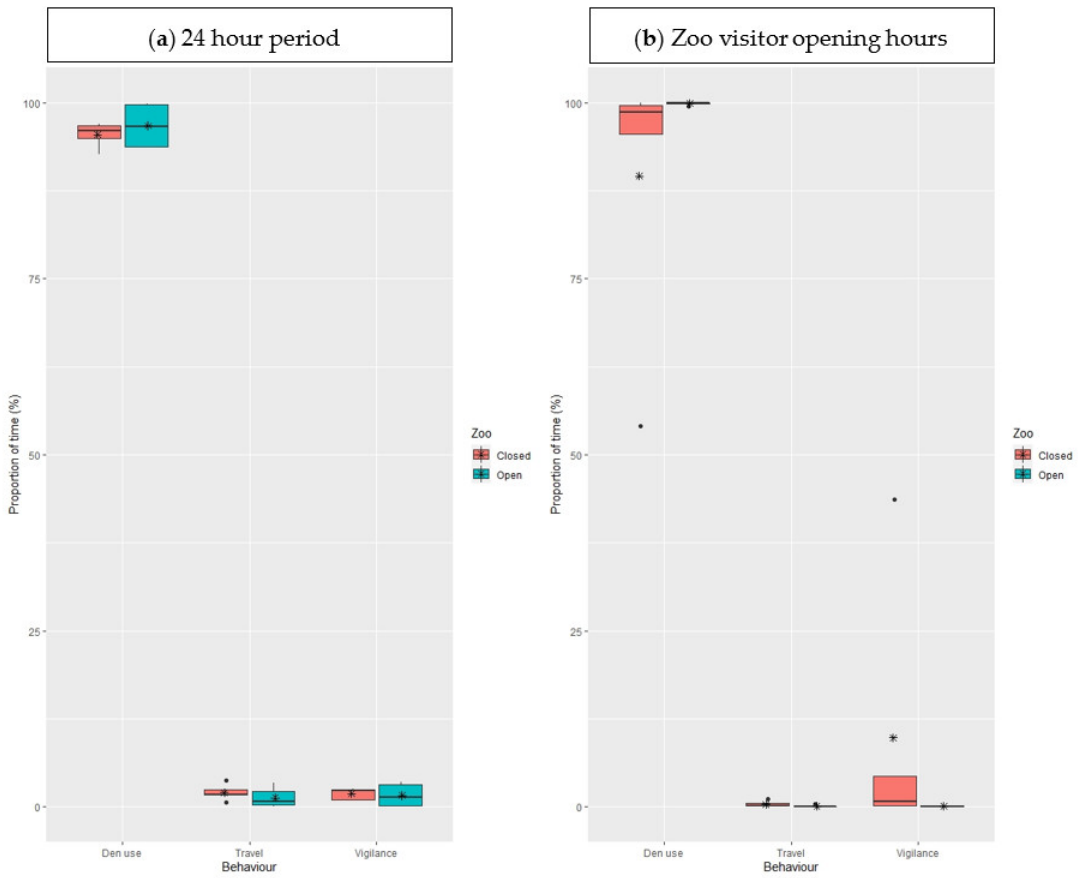
Figure 3. Proportion of time (%) two zoo-housed Palawan binturong ( Arctictis binturong whitei ) en- gaged in three behavioral categories throughout ‘Zoo open’ and ‘Zoo closed’ data collection periods over ( a ) 24 h period and ( b ) during zoo visitor opening hours (10:00–16:30). Time budgets displayed using boxplots outlining the first quartile, median, third quartile and range of the data. Black circles indicate outliers. Black star denotes the mean value of time spent engaging in each behavior cate- gory.